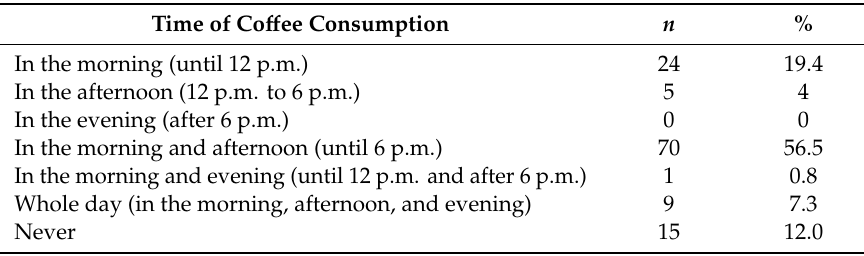
Table 5. Time of co ff ee